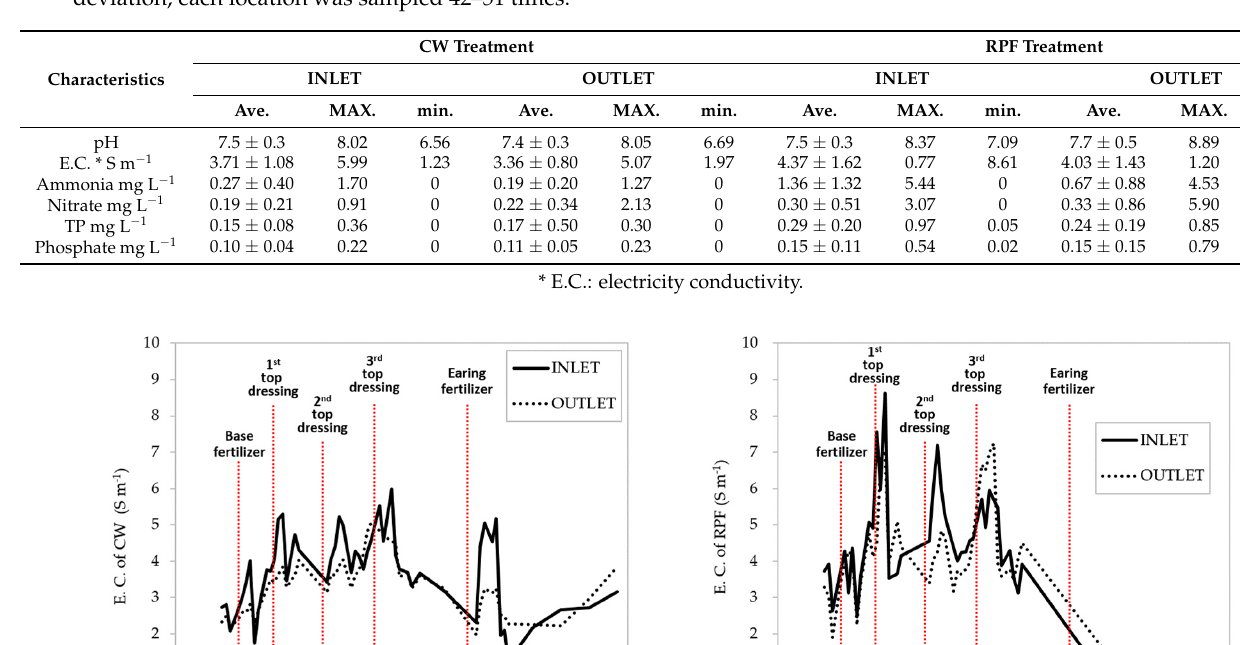
Table 3. Chemical characteristics of INLET and OUTLET of the first crop season, 2020 (March–June); mean ± standard deviation; each location was sampled 42–51 times.